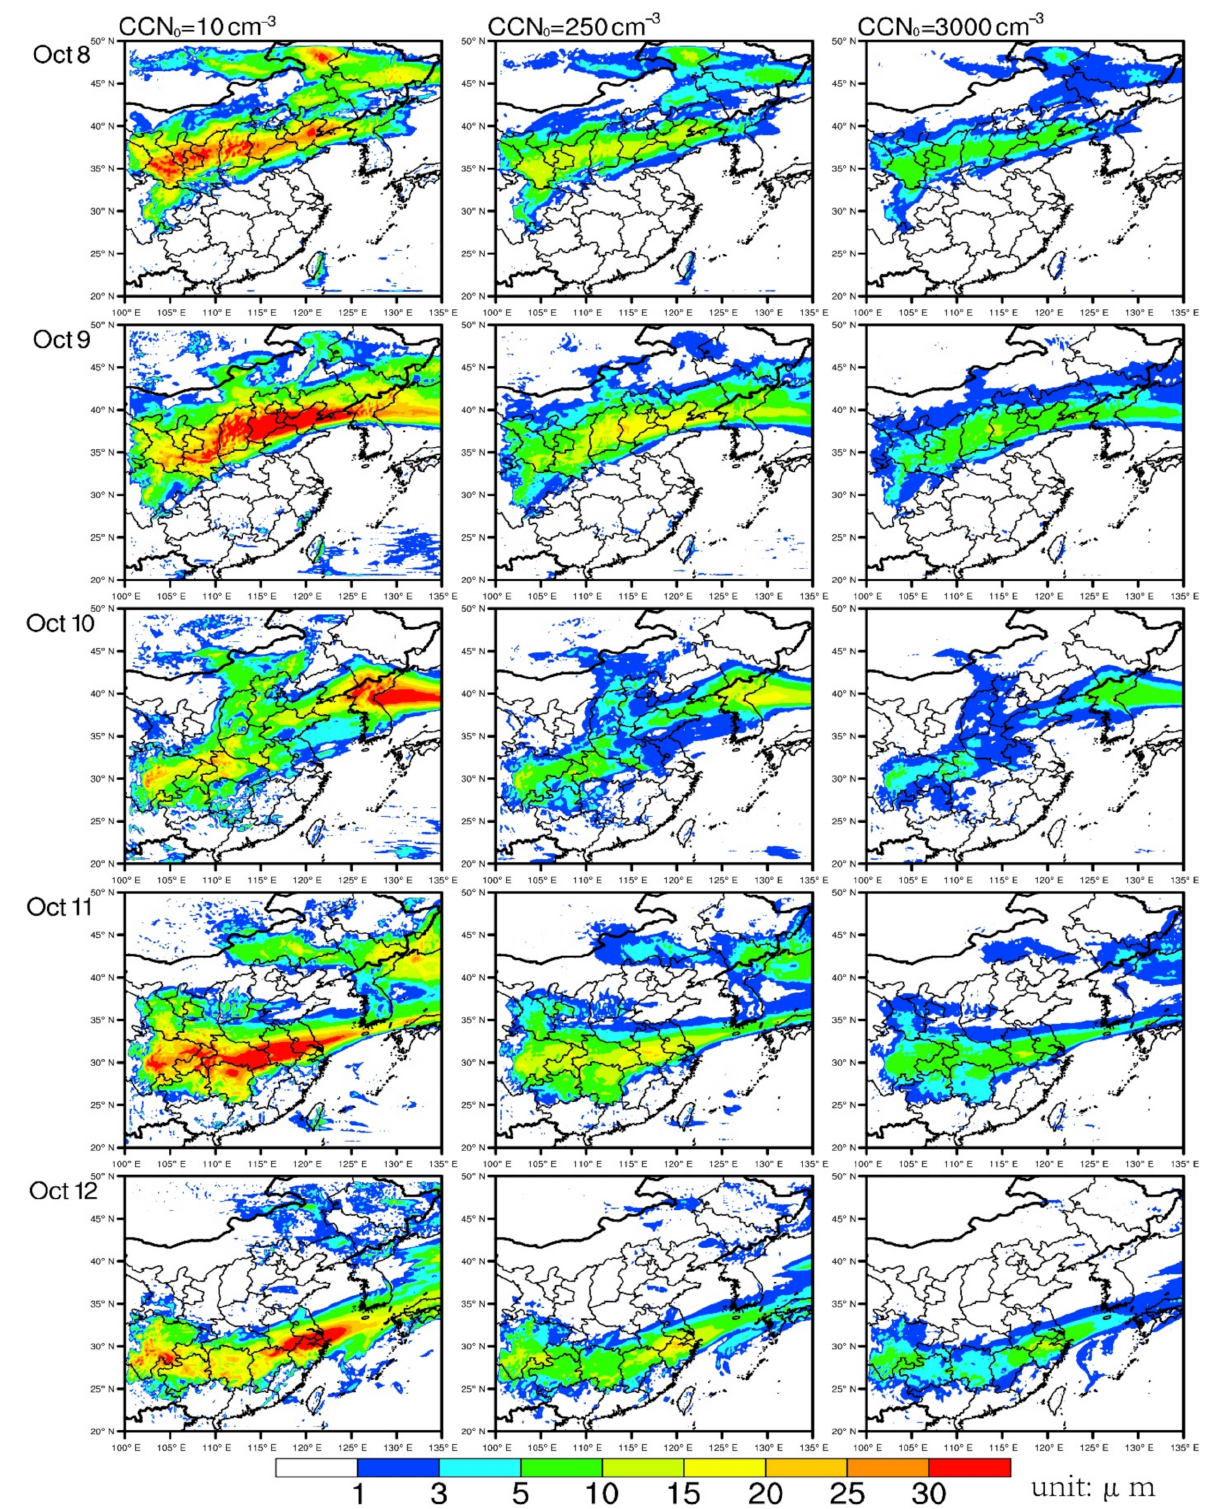
Figure 4. Daily averaged Rc ( µ m) by model from 8 to 12 October ( left : CCN 0 = 10 cm − 3 , mid : CCN 0 = 250 cm − 3 , right : CCN 0 = 3000 cm − 3